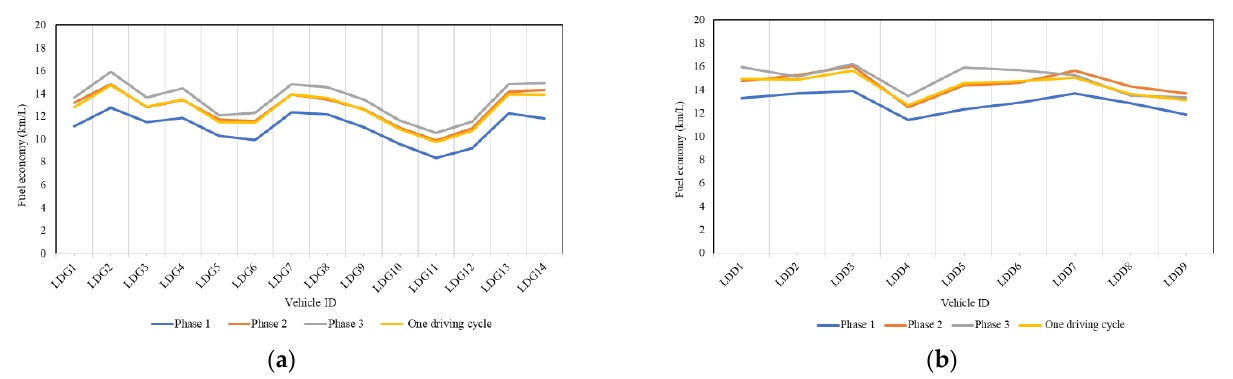
Figure 4. Fuel economy rate (km/L) for ( a ) LDG and ( b ) LDD vehicles.